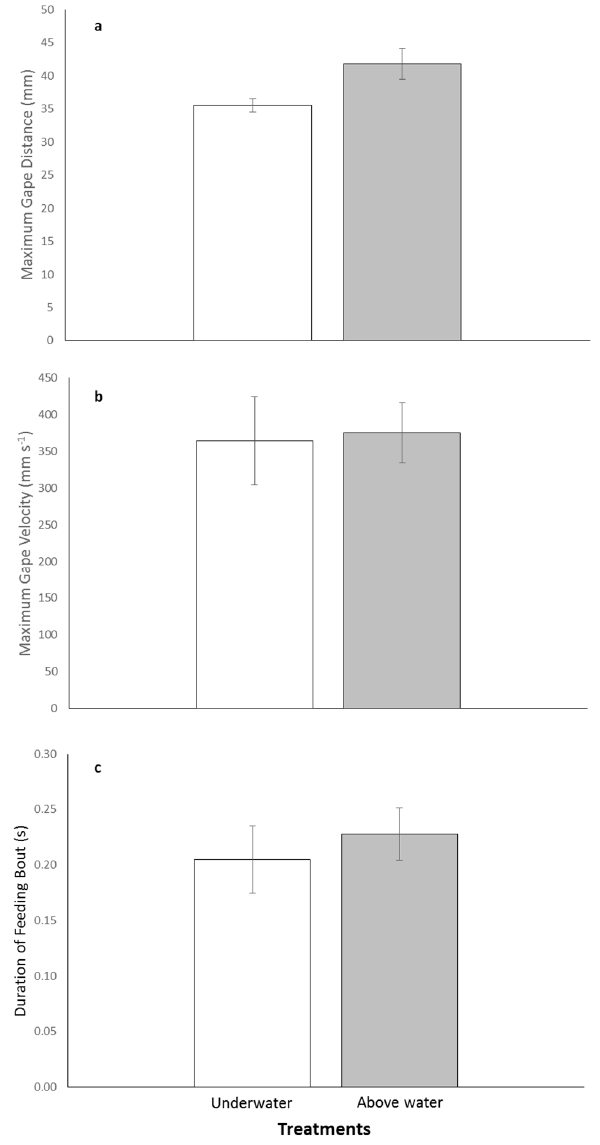
Figure 2. Bar graphs depicting the mean ± SE for kinematic variables: ( a ) maximum gape distance ( b ) maximum gape velocity and ( c ) duration of feeding bout. Open bars represent the underwater treatment and shaded bars represent the above water treatment. Table 2. Results of the paired statistical analyses performed on kinematic variables. The Bonferoni corrected α -level for determining the statistical significance was set at 0.0167 for the kinematic variables and 0.050 for the variable involving successful strikes.